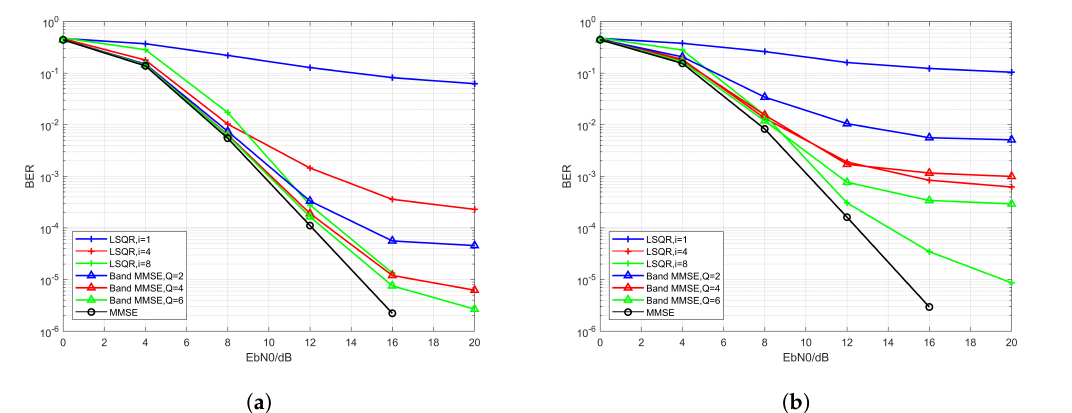
Figure 5. BER performance of the MMSE block equalizer, the band MMSE equalizer, and the iterative LSQR equalizer under different Q and i with the normalized Doppler spread of 0.1 ( a ) and 0.3 ( b